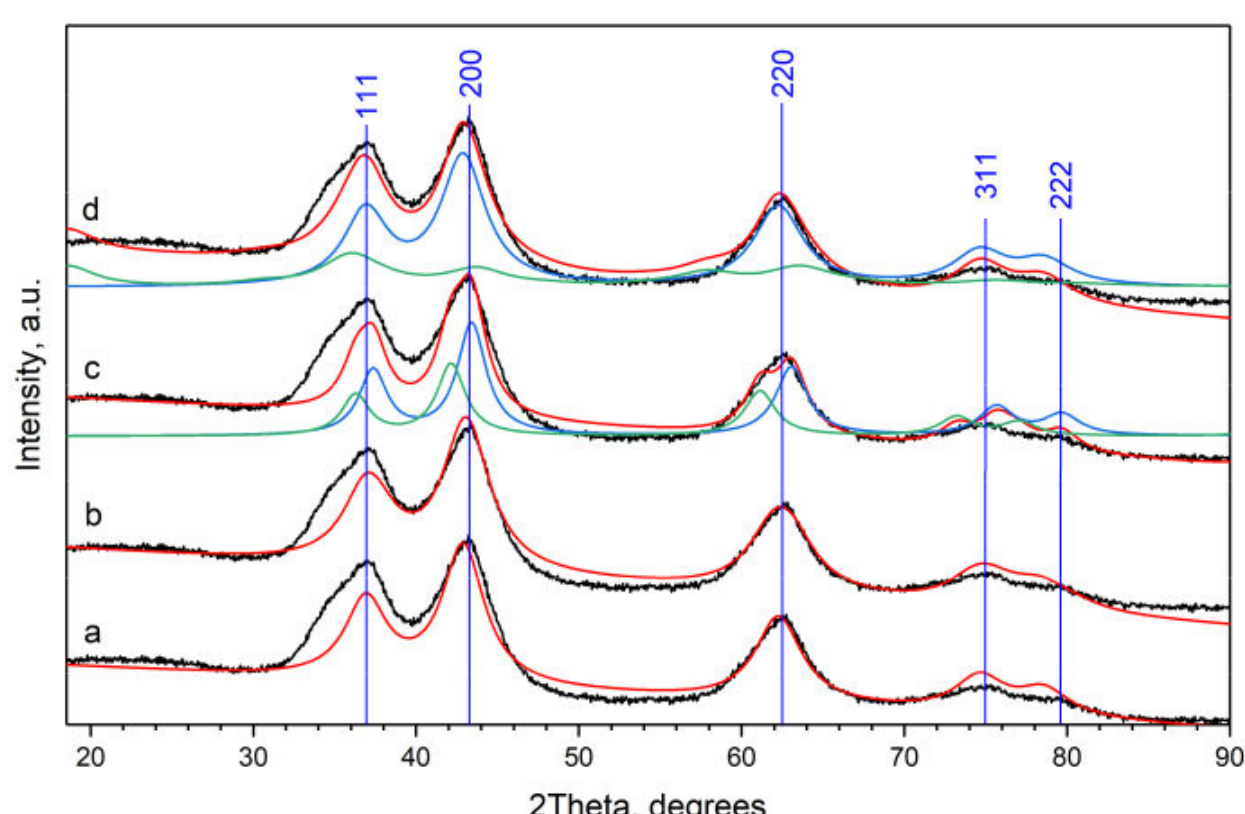
Figure 2. Rietveld analysis on the basis of (a) cubic NiO, (b) rhombohedral NiO, (c) two cubic NiO-like phases (blue and green), and (d) cubic NiO (blue) and cubic Ni2SiO4 (green). Experimental curves are black; calculated curves (the sum of XRD patterns calculated for individual phases and background) are red. Vertical blue lines—the positions of Bragg diffraction peaks for